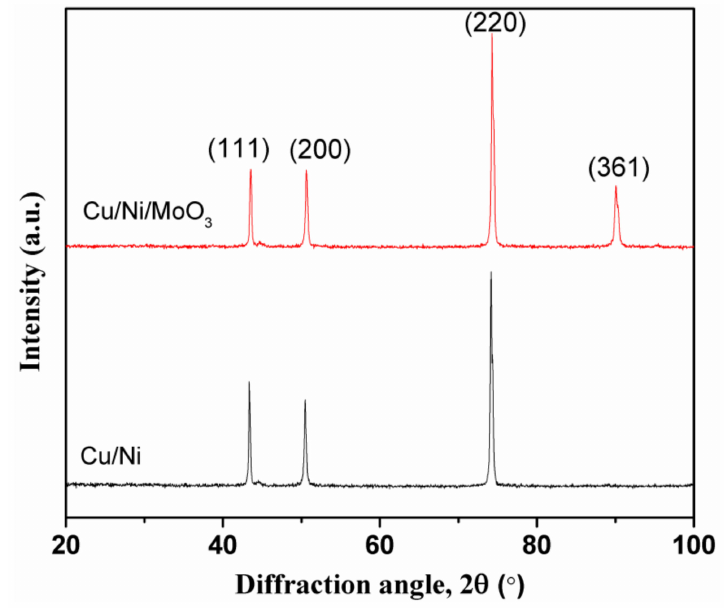
Figure 1. XRD peaks of Cu/Ni and Cu/Ni/MoO 3